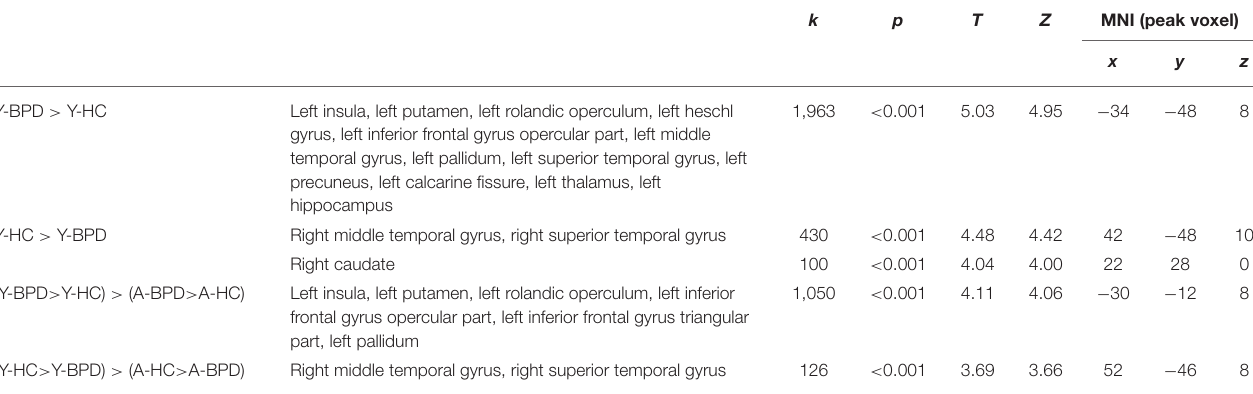
TABLE 4 | Full-Factorial Analysis, whole brain results during other-directed aggression phase, p < 0.001 and cluster size k ≥ 88.